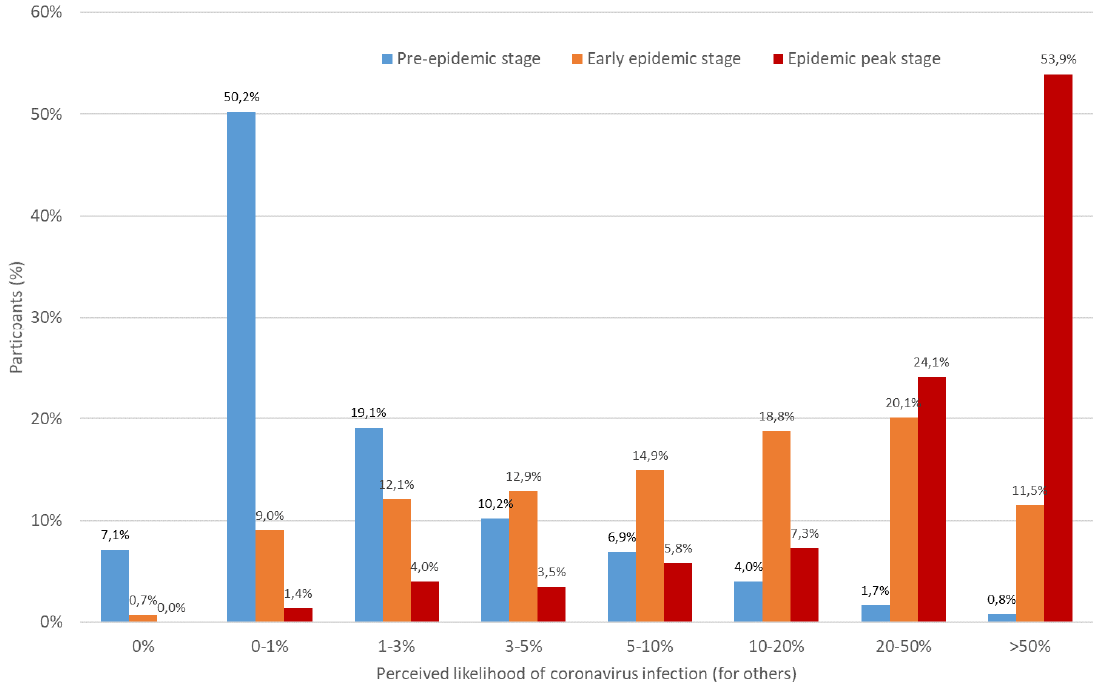
Figure 2. Perceived likelihood of COVID-19 infection for others at the pre, early and peak epidemic stages.